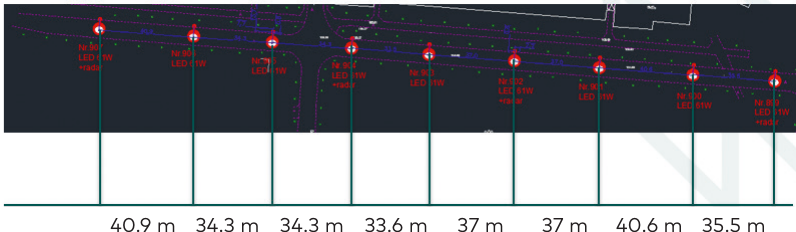
Figure 6. Sample of AutoCAD format (*.dwg file) topographical